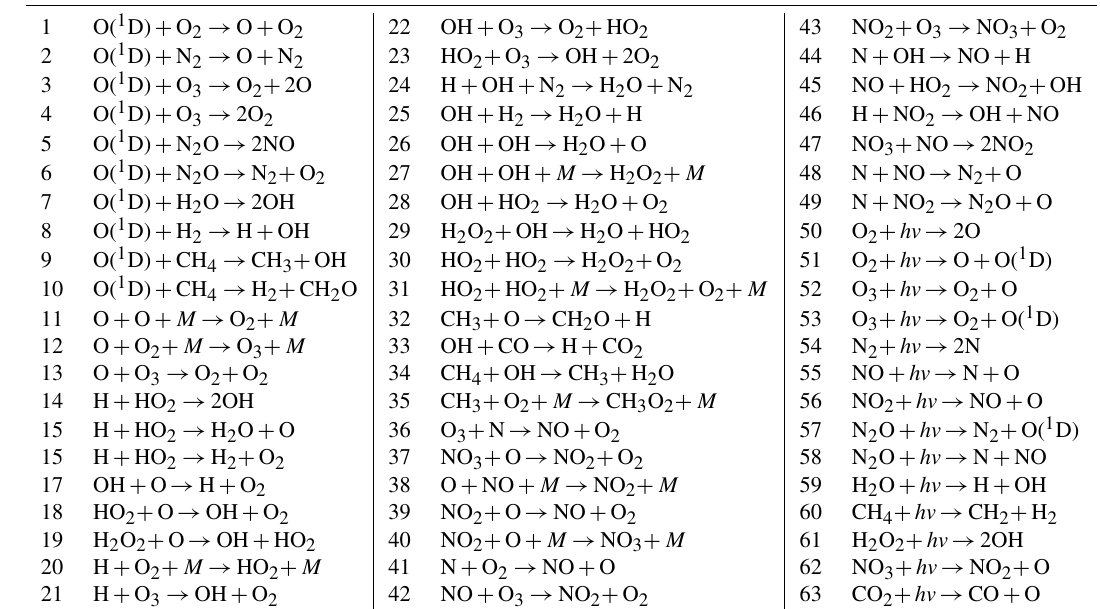
Table 1. List of